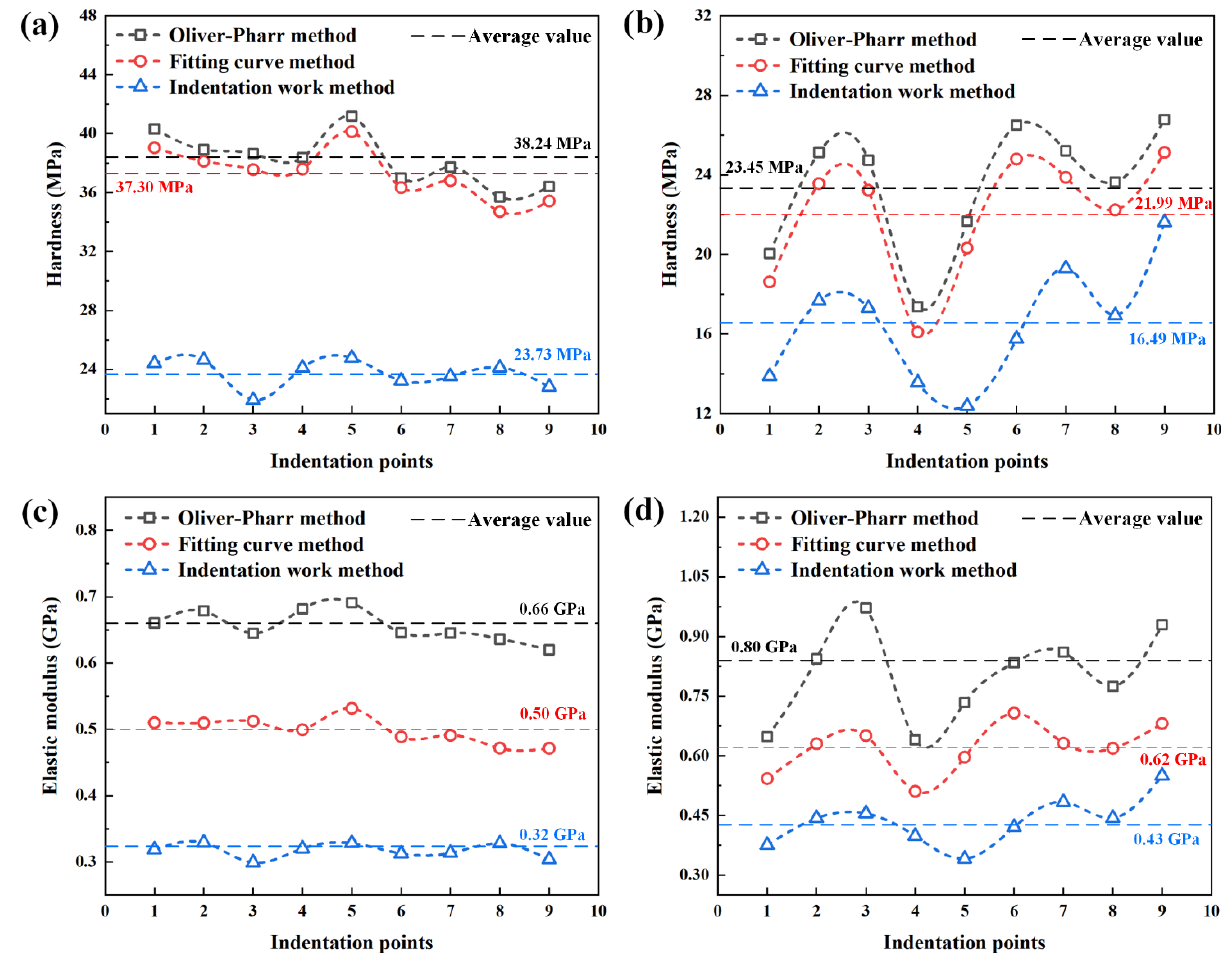
Figure 9. Hardness and elastic modulus of specimens determined by Oliver–Pharr method, inden- tation work method and fitting curve method: ( a ) hardness of PP/PE/PP separator; ( b ) hardness of PE separator; ( c ) elastic modulus of PP/PE/PP separator; ( d ) elastic modulus of PE separator.